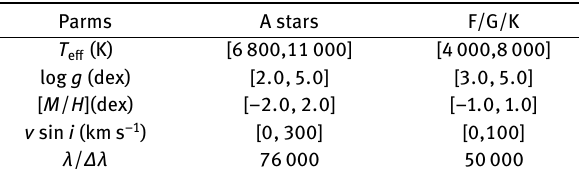
Table 1. Ranges of the parameters used for the calculation of the A and FGK synthetic spectra LDB